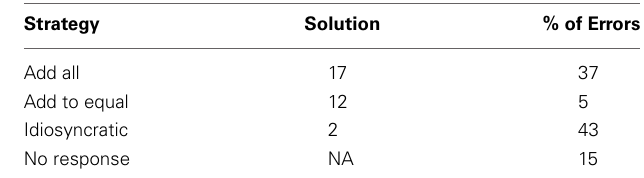
Table 2 | Incorrect strategies for solving the equivalence